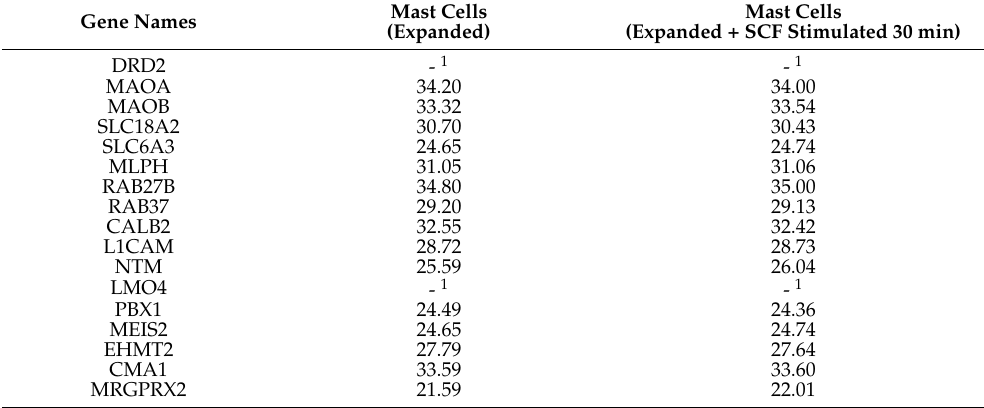
Table 3. Protein abundance of selected proteins in the proteomics study from our group (manuscript in preparation). The Global proteome in skin mast was analyzed by LC-MS/MS. Protein abundance was represented as log2 LFQ (Untargeted label-free quantitation) score. Higher LFQ values indicate higher expression of the mentioned protein in the indicated samples. CMA1 and MRGPRX2 are not discussed herein but were added for comparison as MC-selective entities. Note that SCF stimulation was performed for a short time only (to detect phosphoproteins); therefore, no changes against expanded baseline cells were expected in accordance with the findings. Thus, this table does not intend to demonstrate regulation by SCF over the observation period. Conversely, it aims to show the good correspondence of the two independent samples to underline robustness of the measured LFQ